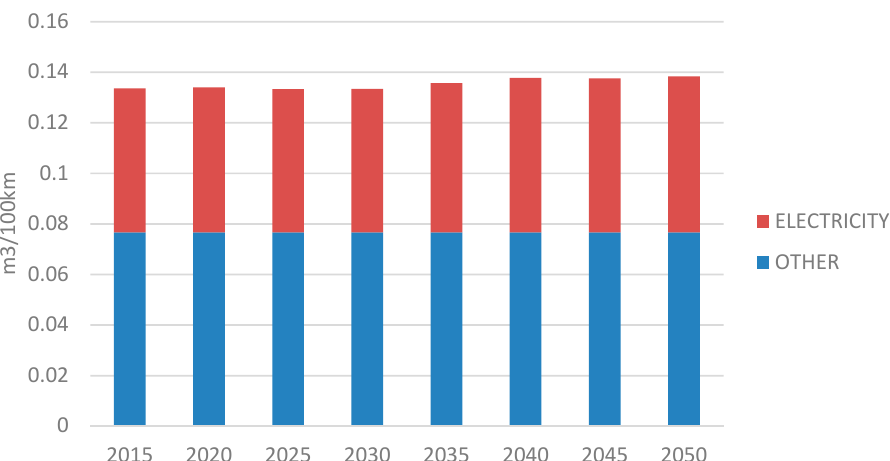
Figure 5. Results of the carbon footprint for electric vehicles in the CR (current and future).